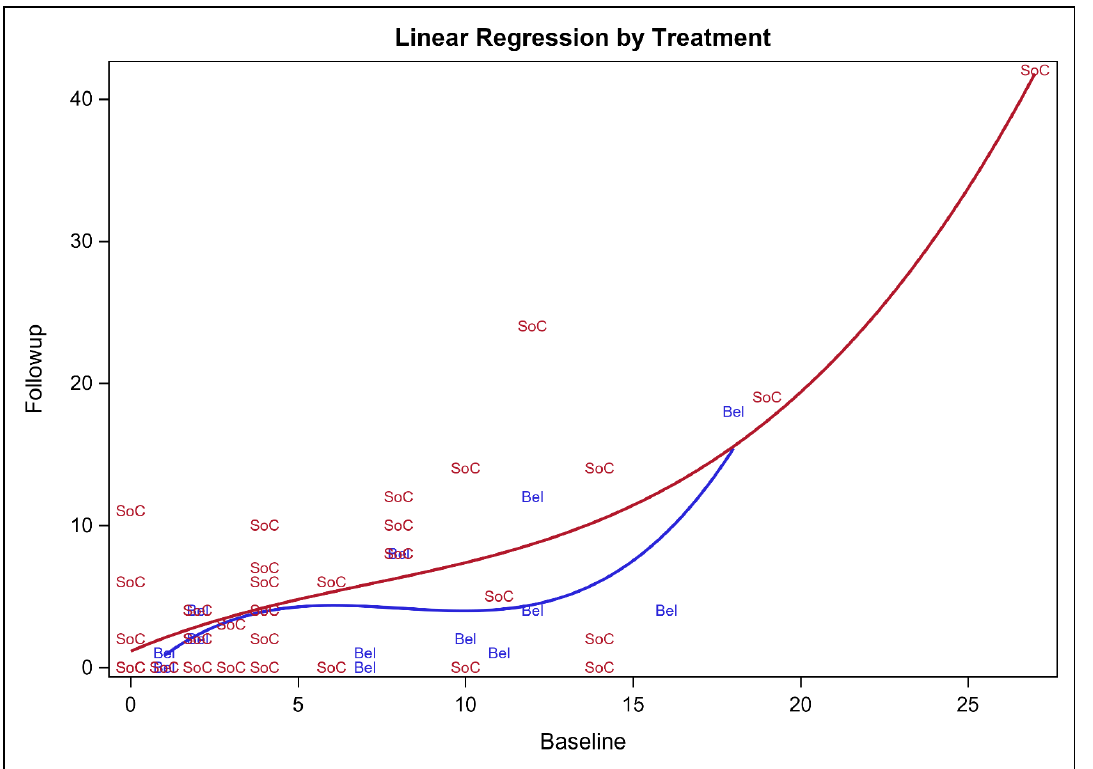
Figure 3. The regression line for the relationship between baseline and follow-up SLEDAI-2K scores for the patients on belimumab (Bel) and the standard of care (SoC). Table 3. Multiple regression analysis for the relationship between the SLEDAI-2K score difference (baseline SLEDAI-2K score–follow-up SLEDAI-2K score) and the use of belimumab versus the standard of care (SoC) for SLE treatment.